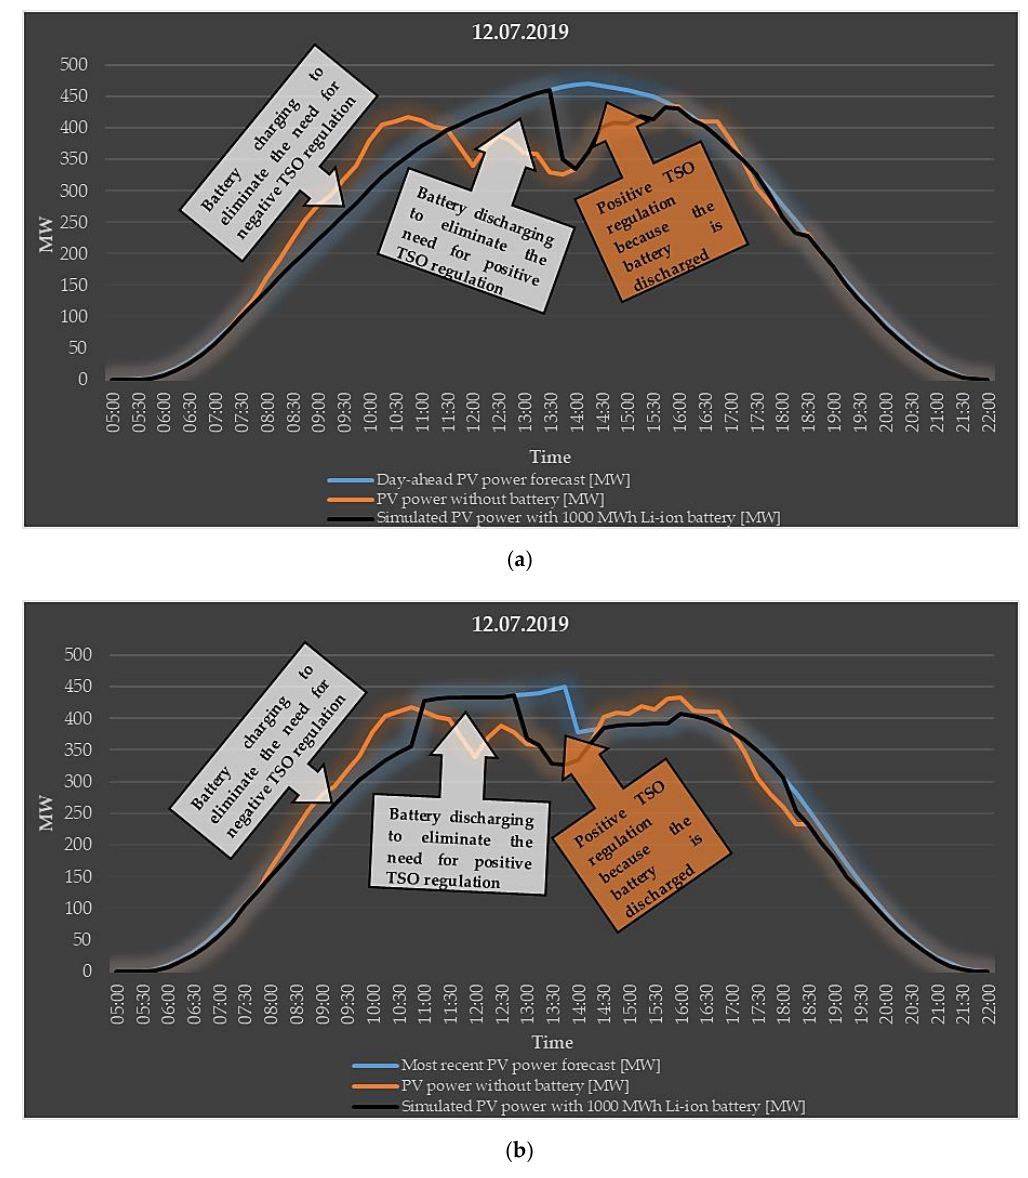
Figure 8. Illustration of the PV plus battery power simulation results by real 1000 MWp PV input data on 12/07/2019, ( a ) day-ahead, ( b ) intraday.